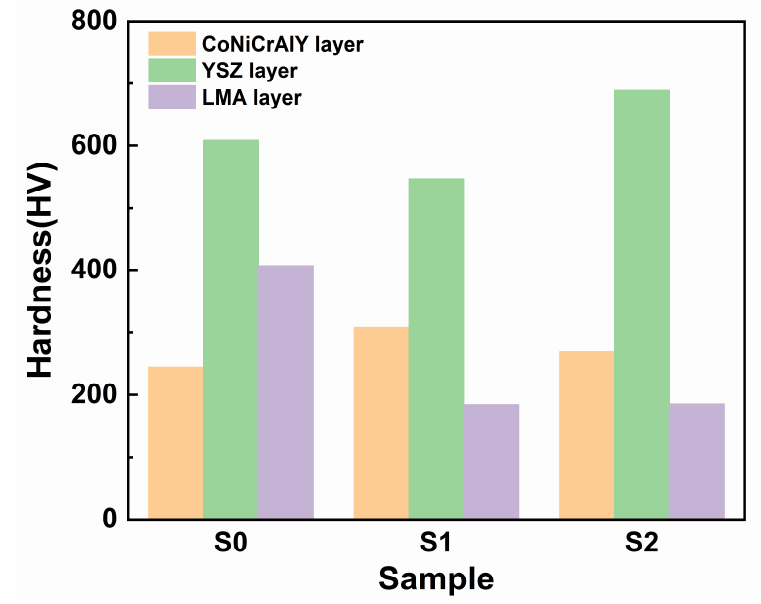
Figure 3. Average microhardness of the sprayed and annealed